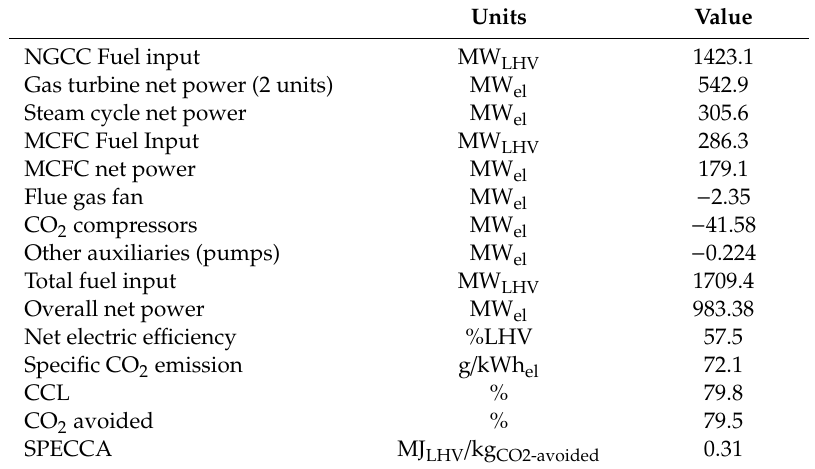
Table 14. molten carbonate fuel cell (MCFC) Performance evaluation outcomes